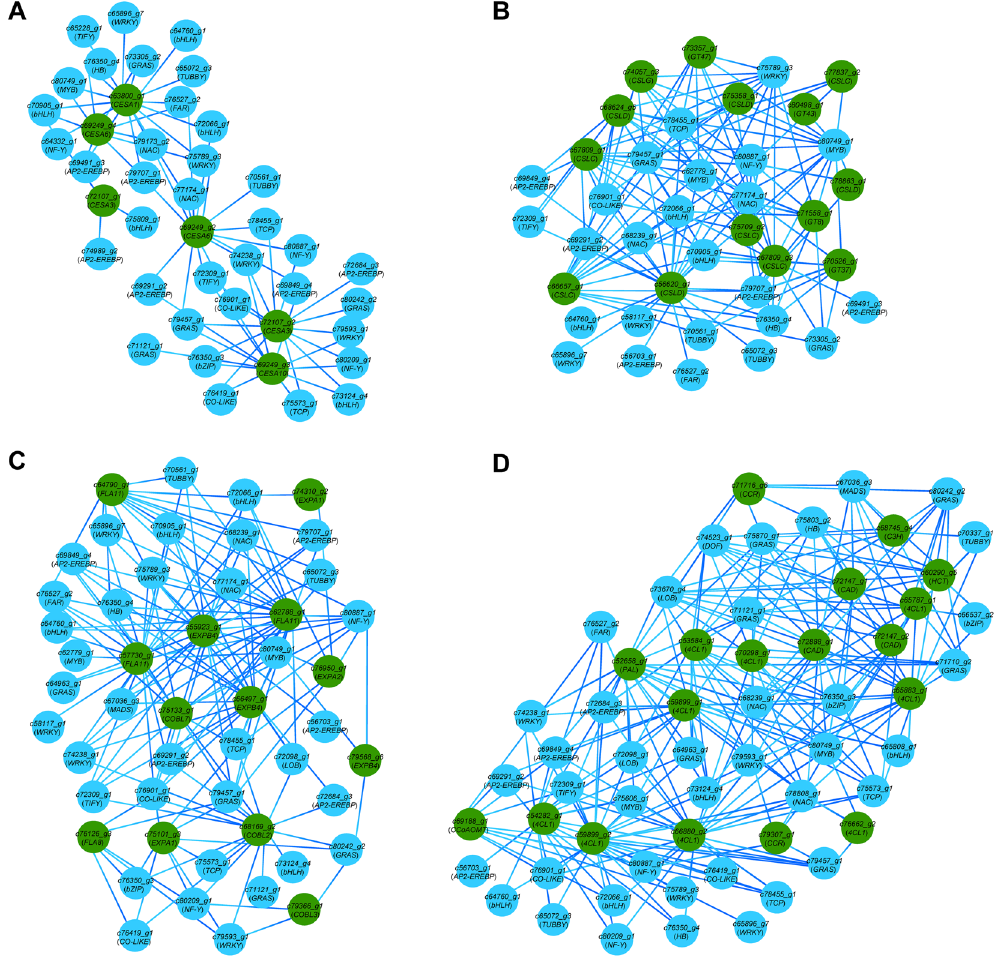
Figure 8. Co-expression network of transcription factors with secondary cell wall biosynthesis genes. Regulatory networks showing transcription factors co-expressed with 6 cellulose synthase genes ( A ), 14 hemicellulose biosynthesis genes ( B ), 13 genes encoding cell wall structural proteins ( C ), and 18monolignol biosynthesis genes ( D ). Transcription factor genes are in blue color and cell wall component biosynthesis genes are in green